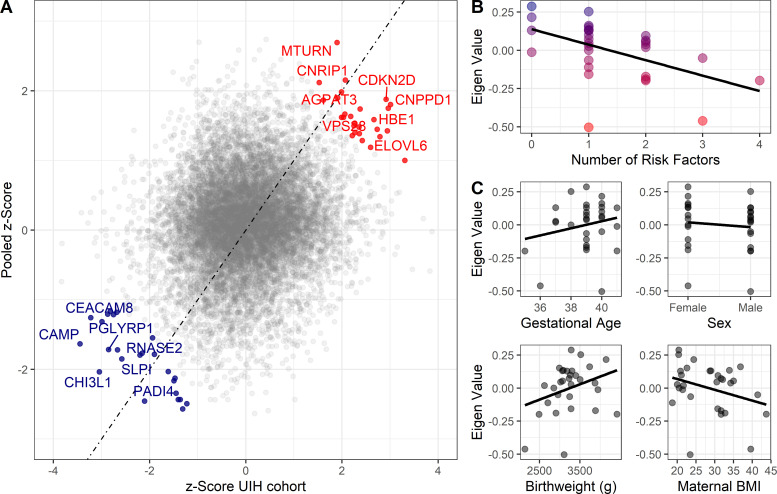
Validation cohort identifies gene signature associated with pediatric asthma risk factors.Color labeling indicating association with either higher (red) or lower (blue) risk of pediatric asthma development. (A) Dot-plot demonstrating validation between meta-analysis pooled z-score and UIH cohort mRNAseq z-score. Colored and labeled dots indicate those with non-parametric replication score greater than 3 and 4, respectively. (B,C) Association between number of risk factors or individual risk factors and eigenvalue of gene signature (validation score > 3), UIH cohort.